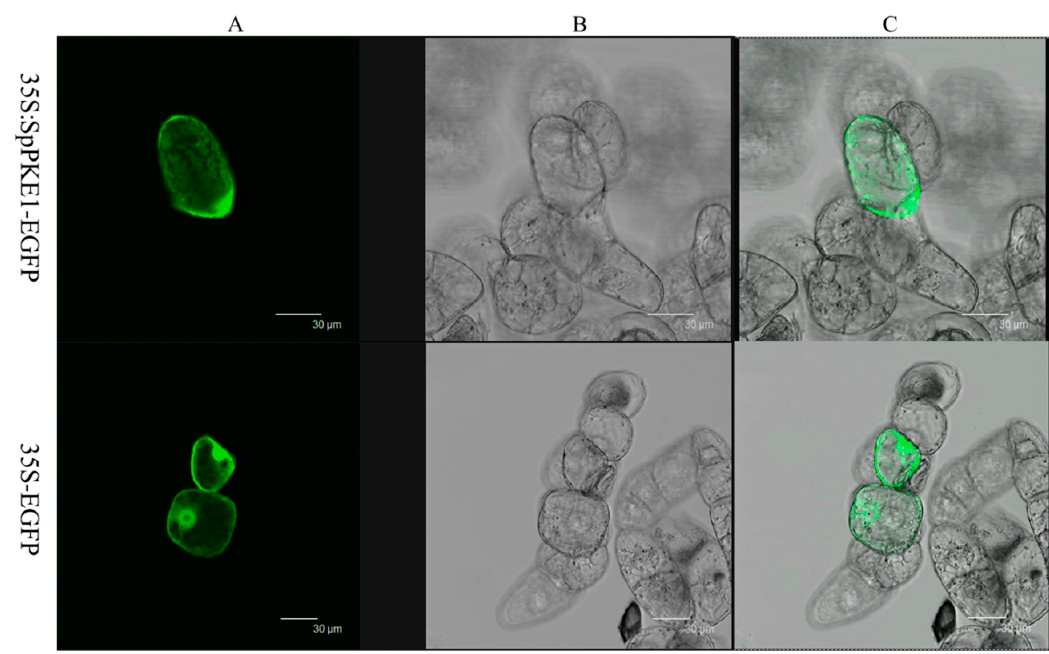
Figure 2. Subcellular localization of SpPKE1 in cv BY ‐ 2 tobacco cells. CaMV 35S:: EGFP and 35S:: SpPKE1 ‐ EGFP constructs were expressed transiently in cv BY ‐ 2 tobacco cells. Green fluorescent protein (GFP) fluorescence images ( A ), Bright ‐ field images ( B ), and merged images ( C ) of representative cells transformed with 35S:: EGFP or 35S:: SpPKE1 ‐ EGFP fusion protein.